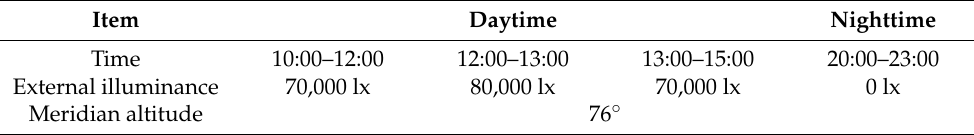
Table 7. The external illuminance and meridian altitude during summer by time period.